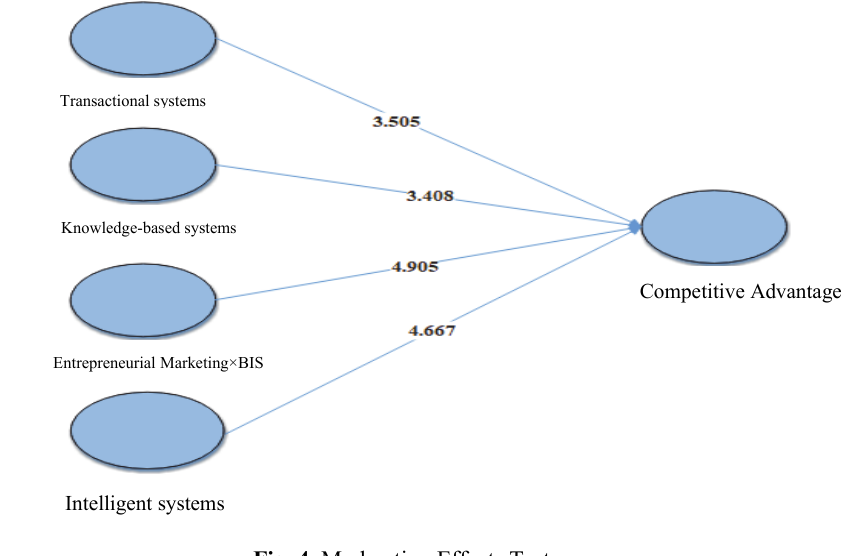
Fig. 4. Moderating Effects Test